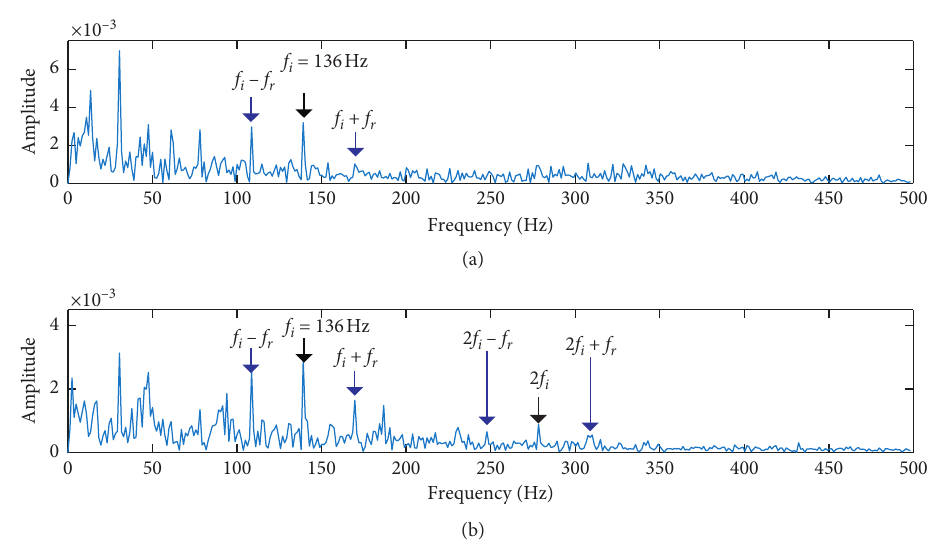
Figure 32: Envelope spectra of the two modes with the larger kurtosis values analyzed by the proposed